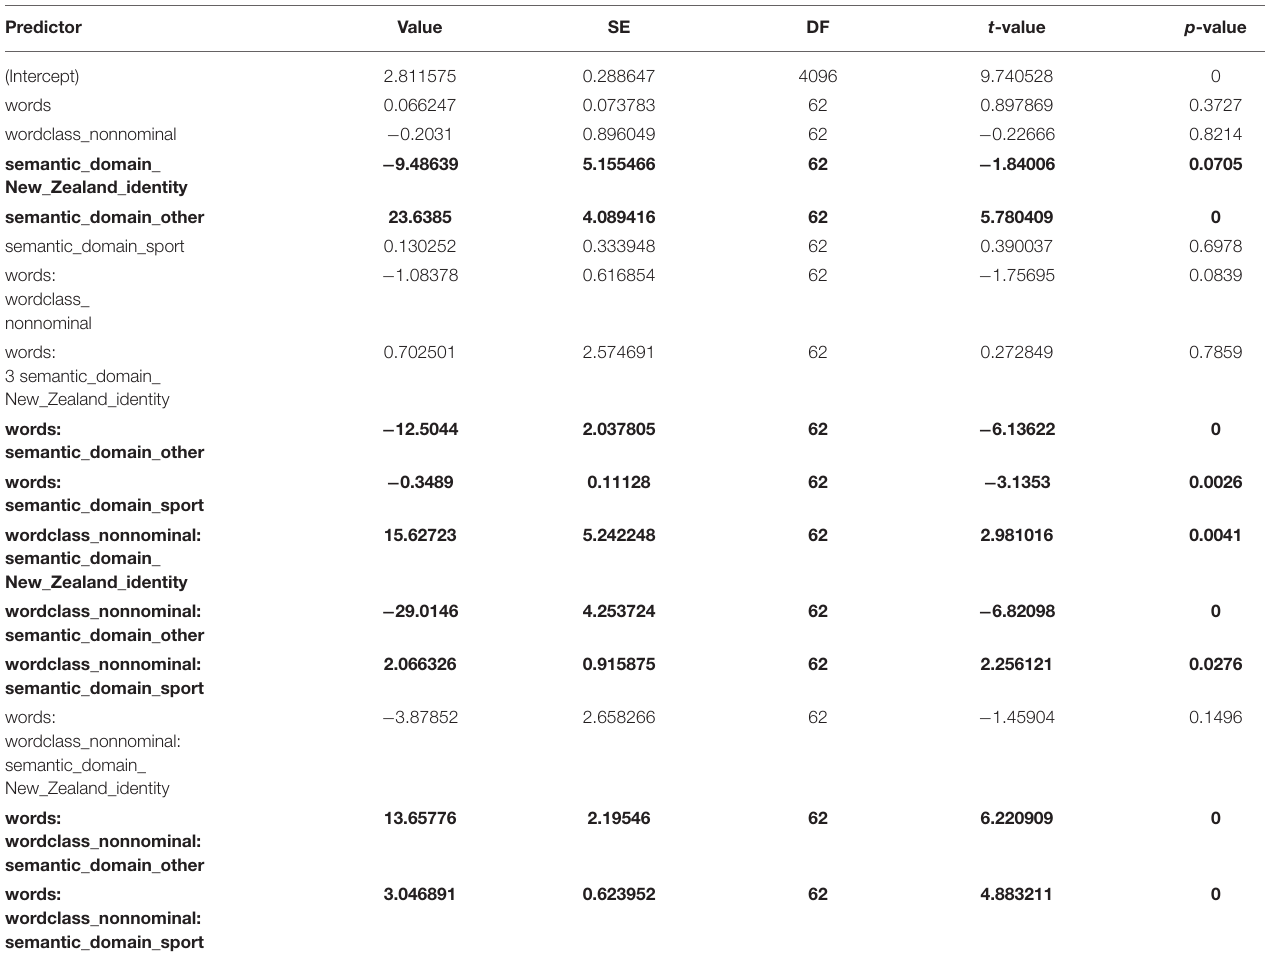
TABLE 6 | Detailed summary of the GLMM model. Predictor